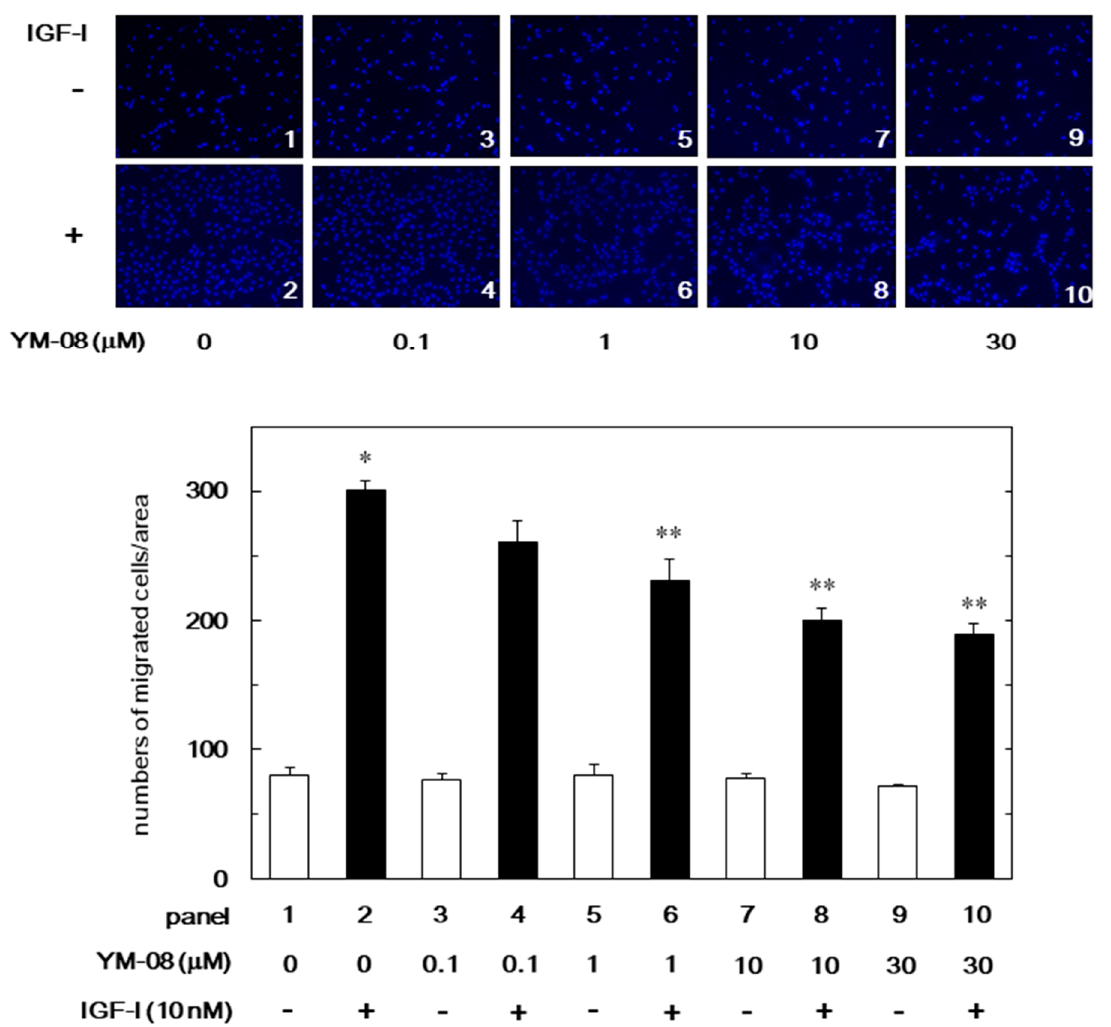
Figure 4. Effect of YM-08 on the IGF-I-induced migration of MC3T3-E1 cells. The migration was evaluated by using a Boyden chamber. The cells were pre-treated with various doses of YM-08 for 60 min and then stimulated by 10 nM of IGF-I or vehicle for 16 h. The representative photographs from triplicate independent experiments and the histogram showing the numbers of migrated cells in each panel are presented. The white and black bars indicate IGF ( − ) and IGF (+), respectively. The blue spots indicate nucleus of migrated osteoblast stained by DAPI. * p < 0.05 compared to the value of the control cells without IGF-I stimulation. ** p < 0.05 compared to the value of IGF-I alone. Scale bar: 100 µm.